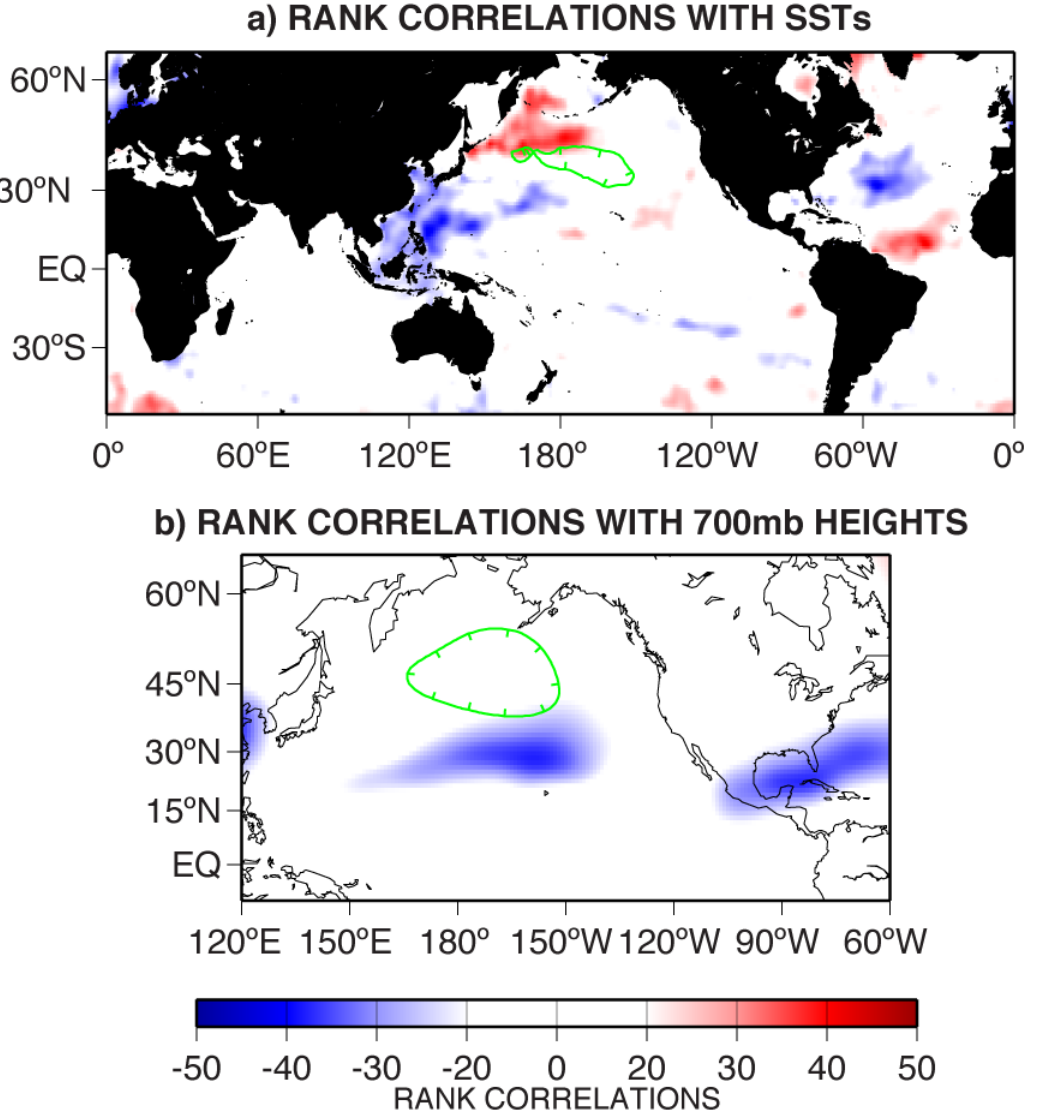
Figure 13. Rank correlations between average PE contributions to water-year precipitation totals at 202 cooperative weather stations in central and northern California (same area defined in Table 3) and concurrent (a) November-April sea-surface temperatures (SSTs), and (b) November-April 700 mbar height anomalies [12]; green hatched shapes in North Pacific surround primary centers of action (largest correlations) with respect to Pacific Decadal Oscillation [31].